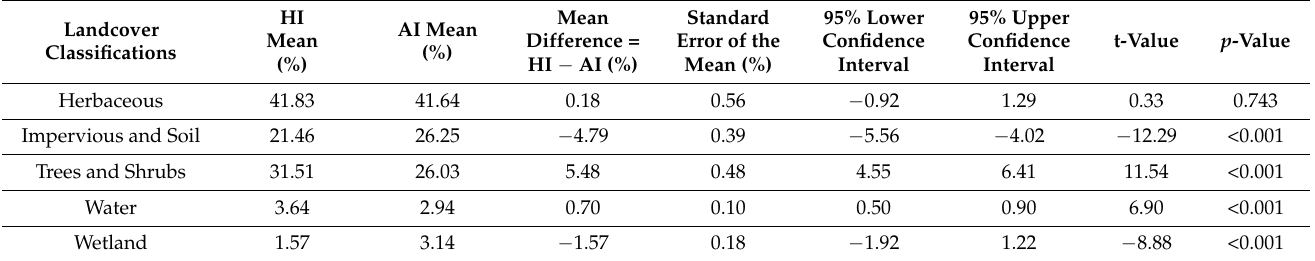
difference for communities in WI, USA using 2013 imagery. n =